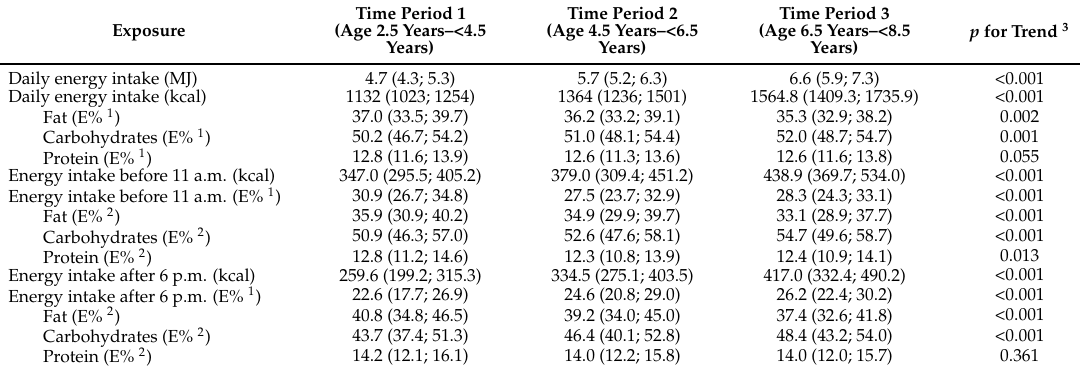
Table 2. Dietary characteristics in three potentially critical time periods (explorative analysis sample, N =